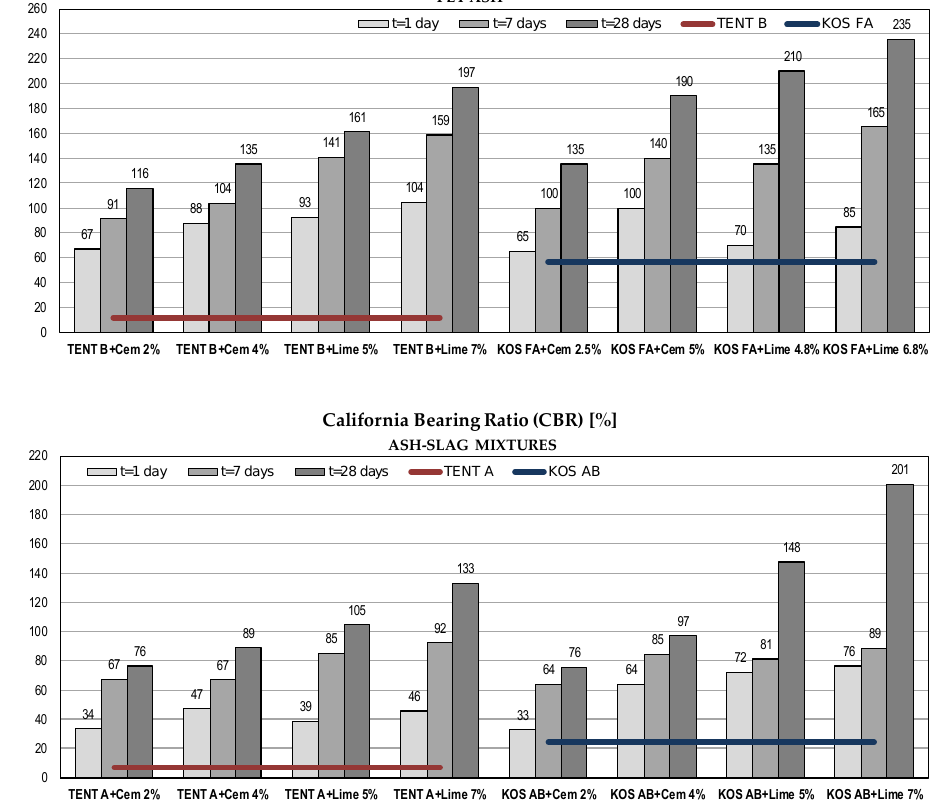
Figure 12. The California bearing ratio of waste materials with binders.